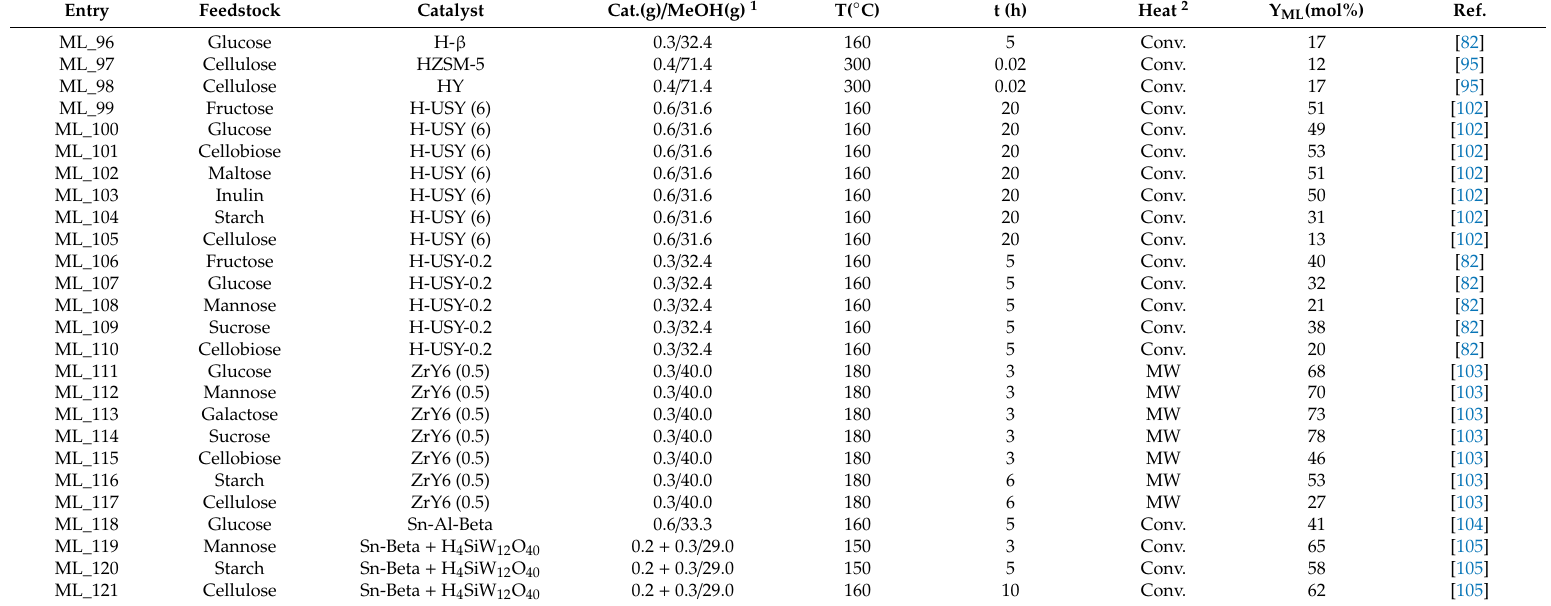
Table 4. Zeolite-based catalysts for the ML production from C6 model